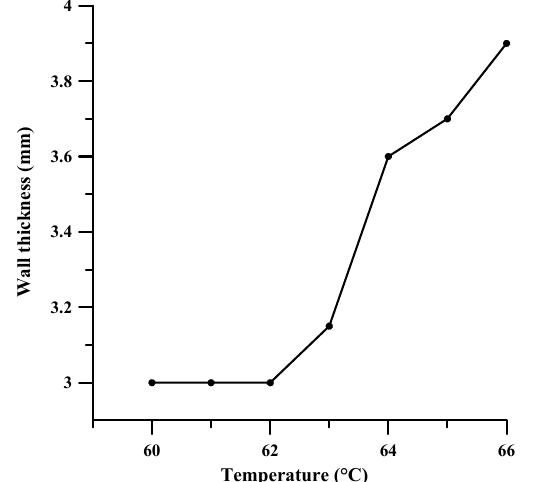
Figure 6. The dependence of wall thickness on temperature printing.